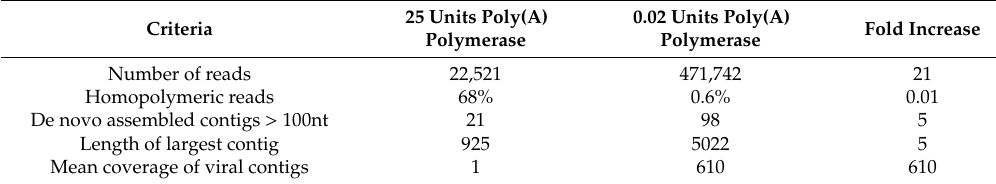
Table 1. Sequencing and assembly statistics for libraries made from dsRNAs polyadenylated with varying poly(A) polymerase